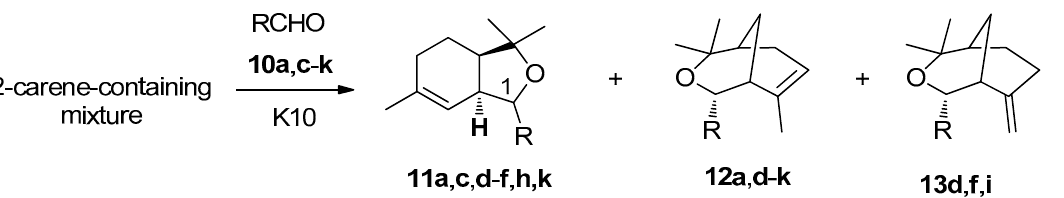
Table 1. Results of reaction of 2-carene-containing mixture with aldehides 10a , c – k . R RCHO R